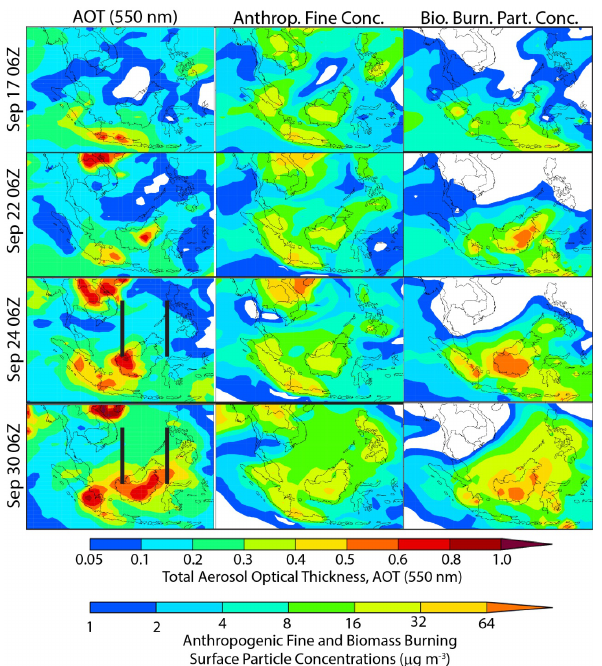
Figure 6. (a–d) Meridional cross sections at 110 and 120 east of NAAPS reanalysis total fine mode aerosol particle concentration for the 25 September (a, c) and 29 September (b, d) haze events. (e) CALIOP 532 nm backscatter across the SCS/ES region on 1 October 2011. (f) Rescaling of (e) for the lowest 4km. Included is a map of the CALIPSO